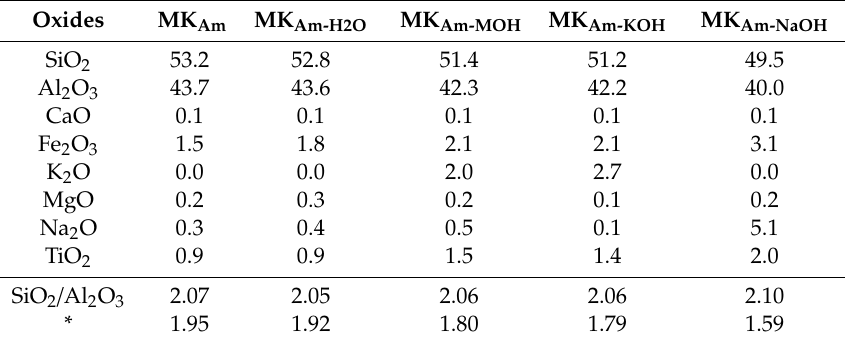
Table 7. Chemical composition [wt.%] of MK Am left after dissolution with di ff erent solvents of all samples measured with ICP-OES and the molar ratio of SiO 2 / Al 2 O 3 and SiO 2 / (Al 2 O 3 + Fe 2 O 3 + TiO 2 + Na 2 O + K 2